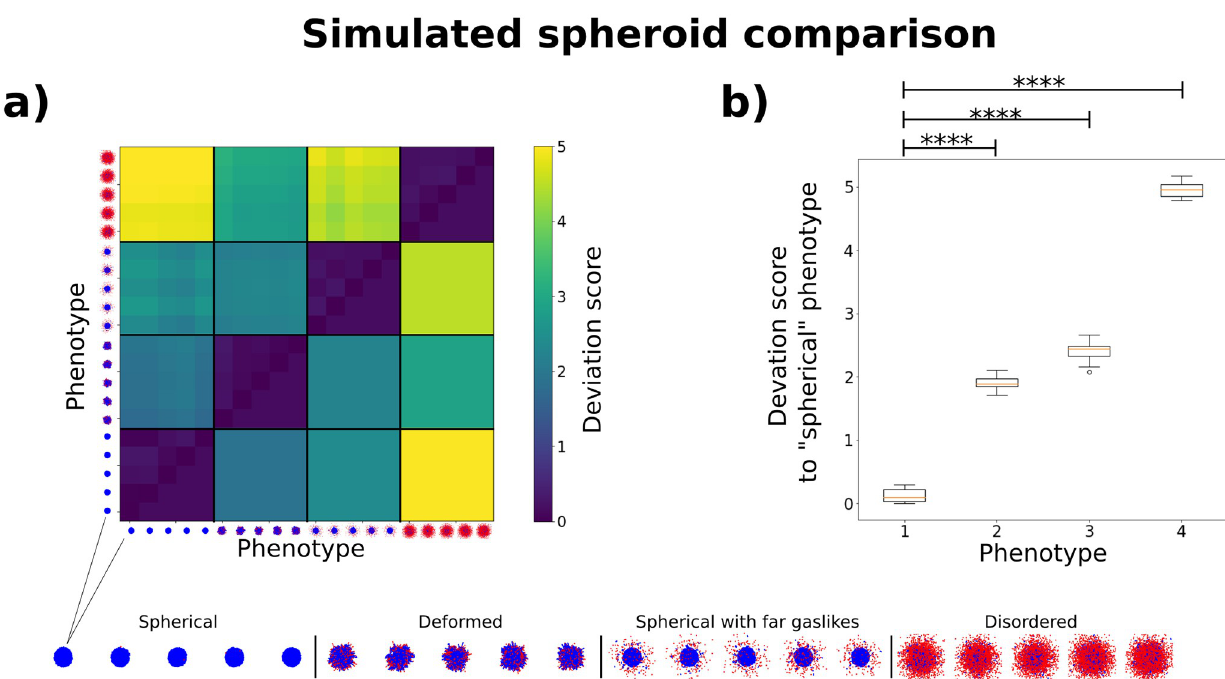
Fig 6. Deviation score comparison for four simulated spheroid phenotypes. a) Shown are the deviation scores for five replicates of each phenotype on the upper triangle, and the average deviation score over all replicates of each phenotype on the lower triangle. A top-down view of the spheroid point cloud for each replicate is shown next to the respective row/column. Blue cells are classified as non-gaslike, and red cells are classified as gaslike. For better comparison, an enlarged version of each spheroid was placed at the bottom of the figure. We observe the highest deviation between the “disordered” phenotype and the others, with the maximum deviation between the “spherical” and the “disordered” phenotypes. The “spherical”, “spherical with far gaslikes” and “deformed” phenotypes, which are more similar from a visual perspective, show a smaller deviation score using our analysis, but are nonetheless distinguishable. b) Box plots of the deviation score values between the “spherical” phenotype and each other phenotype. The values used here correspond to those used for the lowest row of subfigure a). We observe that the deviation scores for the “spherical” phenotype compared with the other phenotypes consistently lie above the maximum deviation score of the “spherical” phenotype compared with itself. Significance was determined using Welch’s